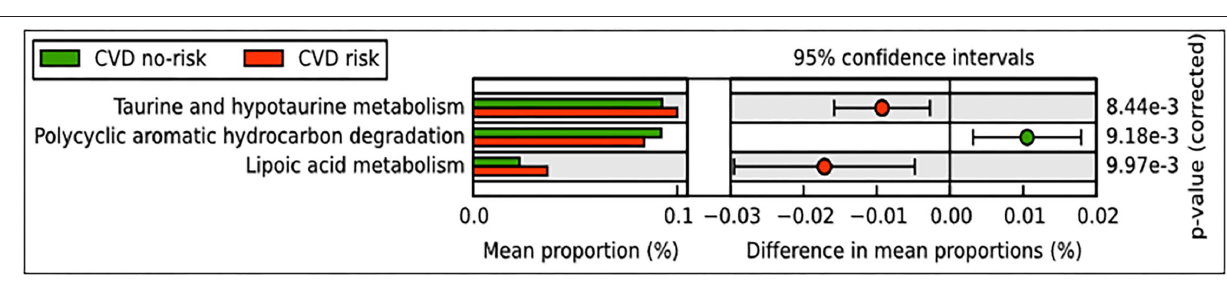
FIGURE 5 | Predicted functional pathways in CVD no-risk and CVD risk groups. Predicted functional pathways were obtained using the PICRUSt method based on bacterial relative abundance shown as mean proportions in the CVD no-risk and CVD risk groups. P < 0.01 was considered statistically significant. CVD no-risk, N = 36; CVD risk, N =